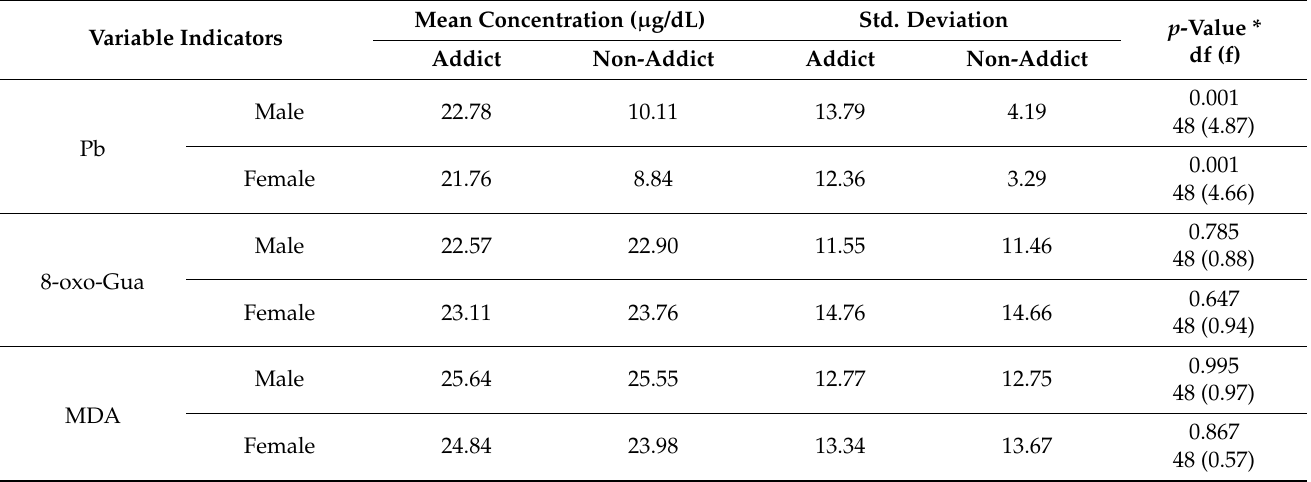
Mean concentration of Pb, 8-oxo-Gua, and MDA in blood serum of addict and non-addict